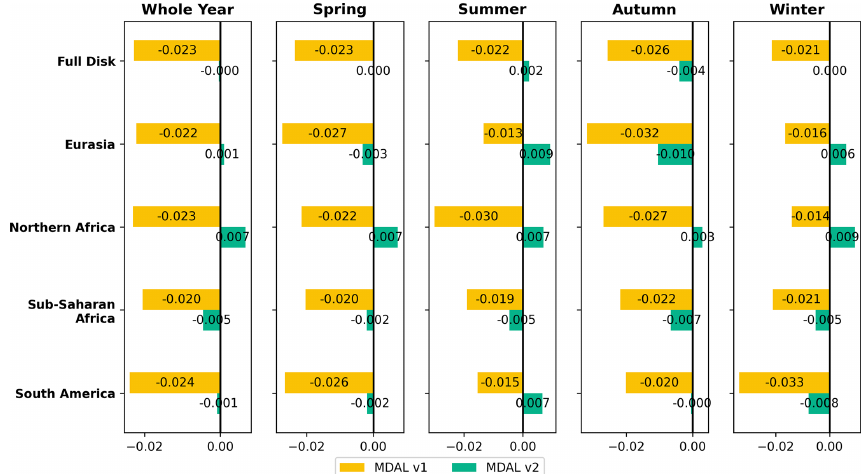
Figure 9. Mean MBE with respect to ETAL by region and season (season names referring to season months of the Northern Hemisphere; spring: MAM; summer: JJA; autumn: SON; winter: